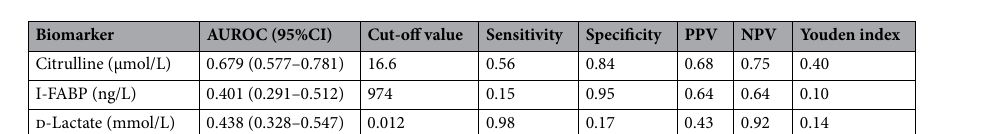
Figure 2. Citrulline, I-FABP and d-lactate plasma concentrations in AMI patients and controls. Abbreviations: I-FABP intestinal fatty-acid binding protein, AMI acute mesenteric ischemia. Comparison of acute abdominal pain controls (n = 79) and patients with AMI (n = 50). The horizontal line in the boxes represents the median, and the bottom and top of the boxes the 25th and 75th percentiles, respectively. I bars represent the upper adjacent value (75th percentile plus 1.5 times the interquartile range) and the lower adjacent value (corresponding formula below the 25th percentile). Outliers are represented by dots (outside of the I bars) and extreme outliers by asterisks (outside of the 75th percentile plus 3 times the interquartile range, or the 25th percentile minus 3 times the interquartile range).